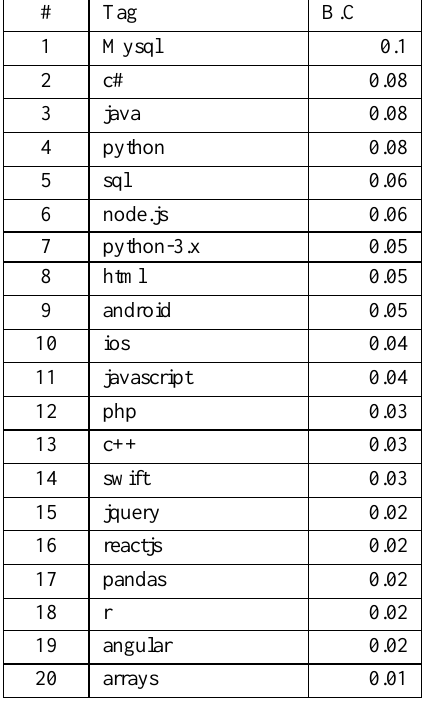
Table 8. Top 20 tags with the highest betweenness centrality.